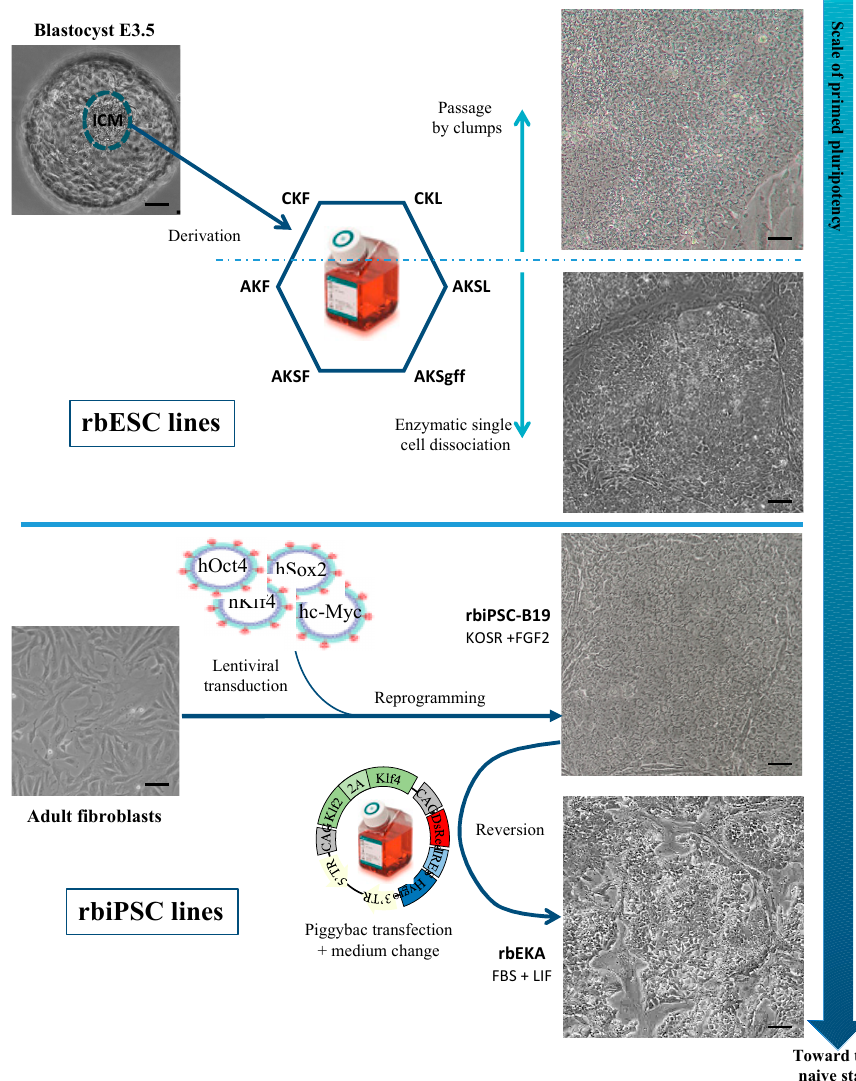
Figure 1. Schematic representation of the rabbit pluripotent stem cell lines produced by our research team [47,51,57] and placed on a scale of primed pluripotency. Methods and media are indicated. rbESC: rabbit embryonic stem cell; rbiPSC: rabbit induced pluripotent stem cell; ICM: inner cell mass; KOSR: knockout serum replacement; FGF2: fibroblast growth factor 2; FBS: fetal bovine serum; LIF: leukemia inhibitory factor; CKF: clumps / KOSR / FGF2; CKL: clumps / KOSR / LIF; AKF: accutase / KOSR / LIF; AKSL: accutase / KOSR + FBS / LIF; AKSF: accutase / KOSR + FBS / LIF; AKSgff: accutase / KOSR + FBS / growth factor free; rbEKA: rabbit enhanced KLF activity. Scale bar = 30 µ